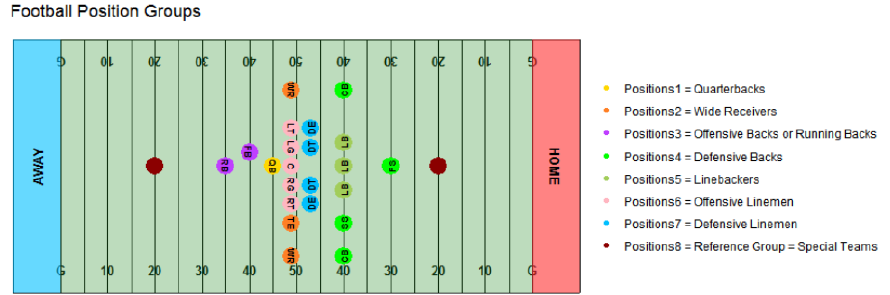
Figure 2. Football position groups. FS = free safety; CB = cornerback; SS = strong safety; LB = linebacker; DE = defensive end; DT = defensive tackle; RB = running back; FB = full back; QB = quarterback; WR = wide receiver; LT = left tackle; LG = left guard; C = center; RG = right guard; RT = right tackle; TE = tight end.